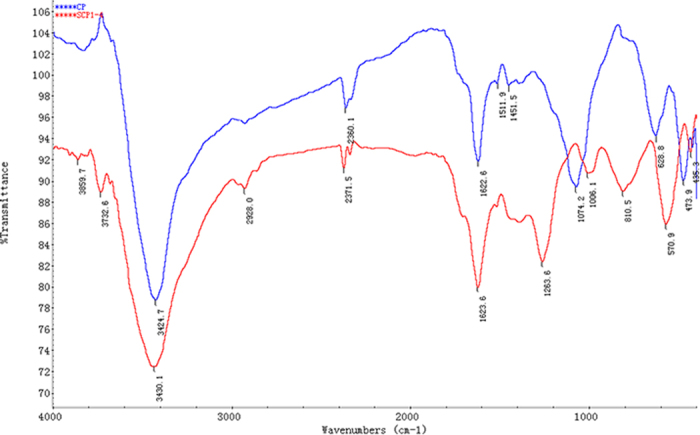
FT-IR spectra of CP (A) and S-CP1–4 (B) between 400 and 4000 cm−1.